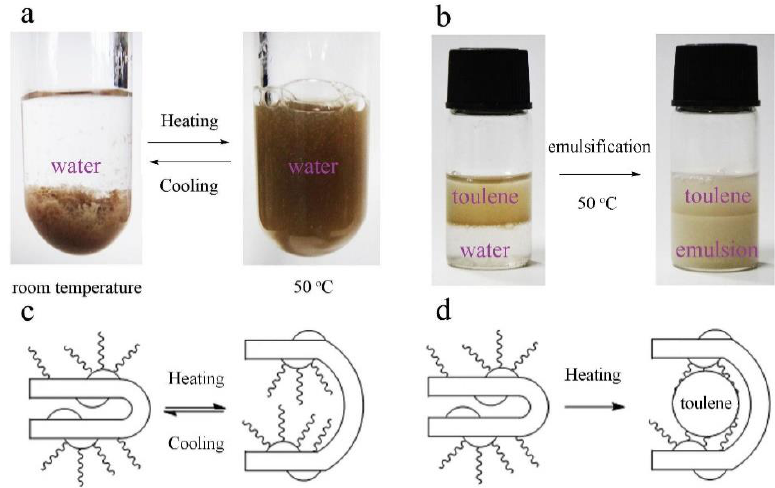
Figure 2. The thermo-responsive property of GO-POM: ( a ) photograph of the aqueous dispersions of GO-POM; ( b ) photograph of the emulsion stabilized by GO-POM with an oil-to-water volume ratio of 1:1 (left: room temperature; right: after heating to 50 °C); ( c ) hydrophobic and hydrophilic nature of GO-POM at different temperatures; and ( d ) emulsion stabilized by GO-POM.